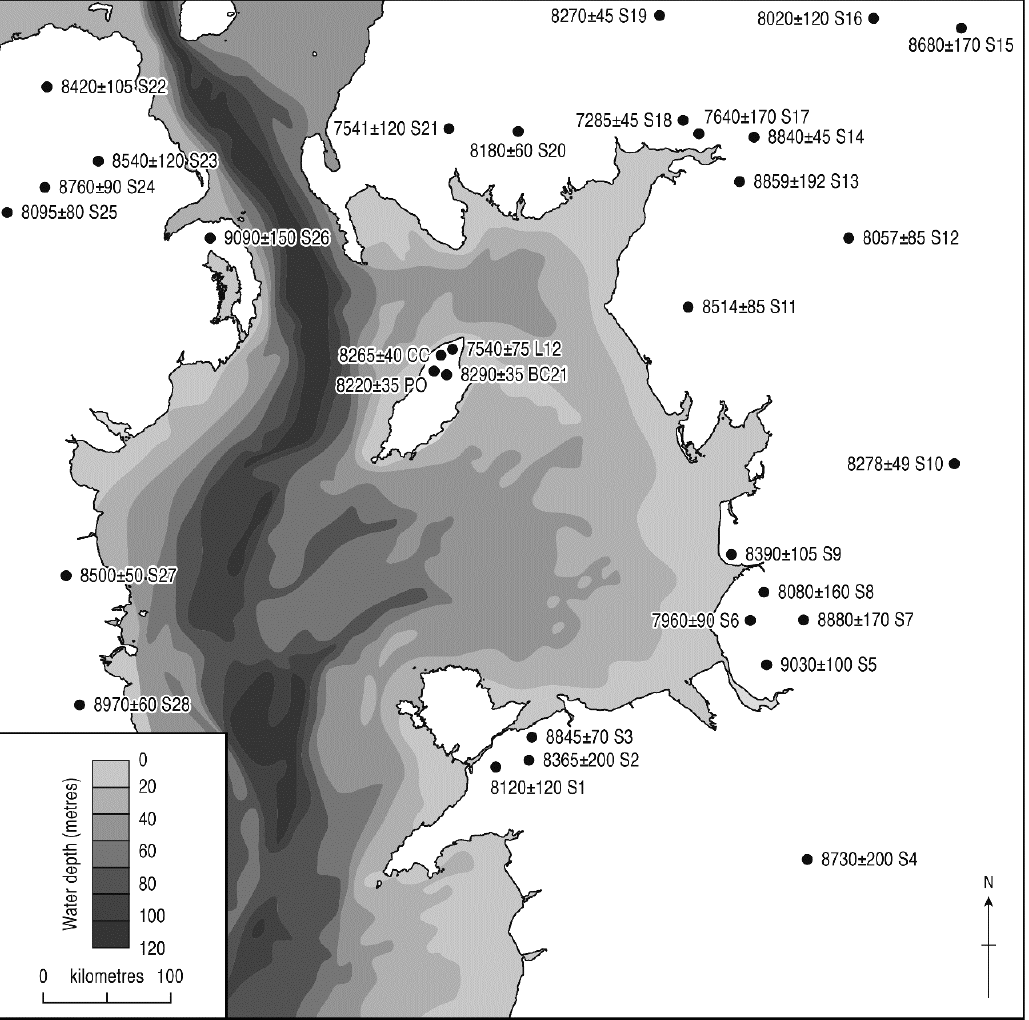
Figure 13. Radiocarbon ages for the Ulmus rise in the northern Irish Sea region. For sources and date calibration ranges see Supplementary File S1.